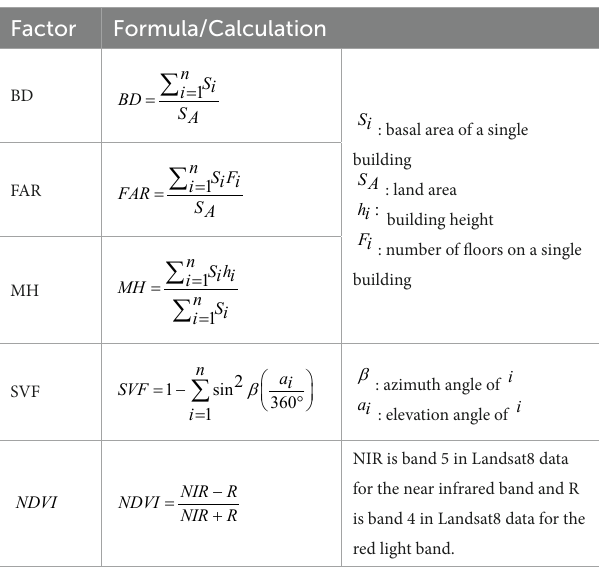
TABLE 1 Definition and calculation of urban spatial